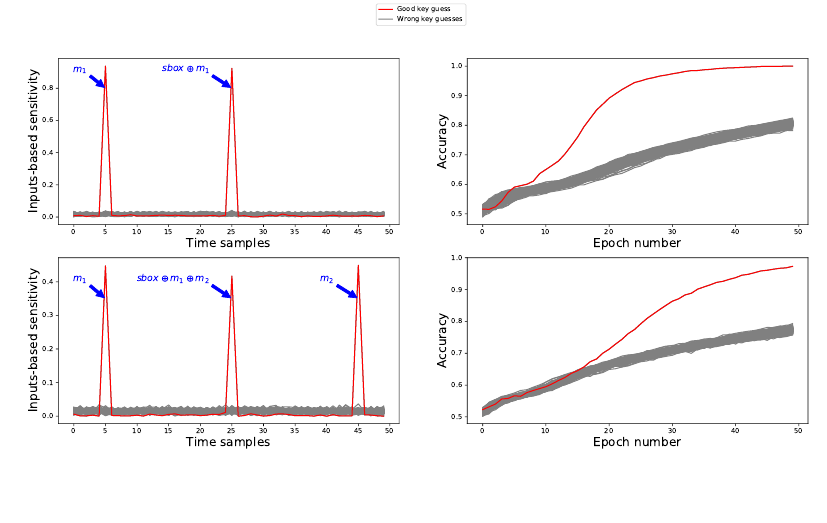
Figure 10: MLP-DDLA applied to 1 and 2 masks protected Sboxes. Top-left: sensitivity for 1 mask. Top-right: accuracies for 1 mask. Bottom left: sensitivity for 2 masks. Bottom right: accuracies for 2